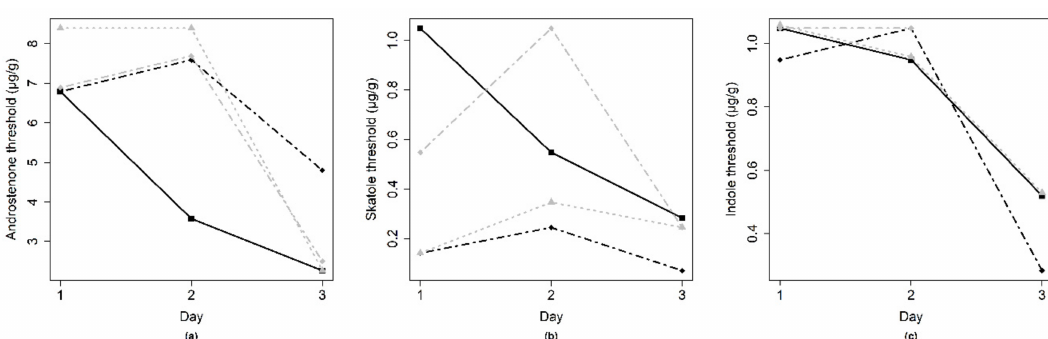
Figure 7. Sensory threshold in fat samples, each line represents the individual thresholds ( y -axis) of a panelist for replicate tests on three di ff erent days ( x -axis). For all compounds, ( a ) androstenone, ( b ) skatole, ( c ) indole, the thresholds varied considerably within and between